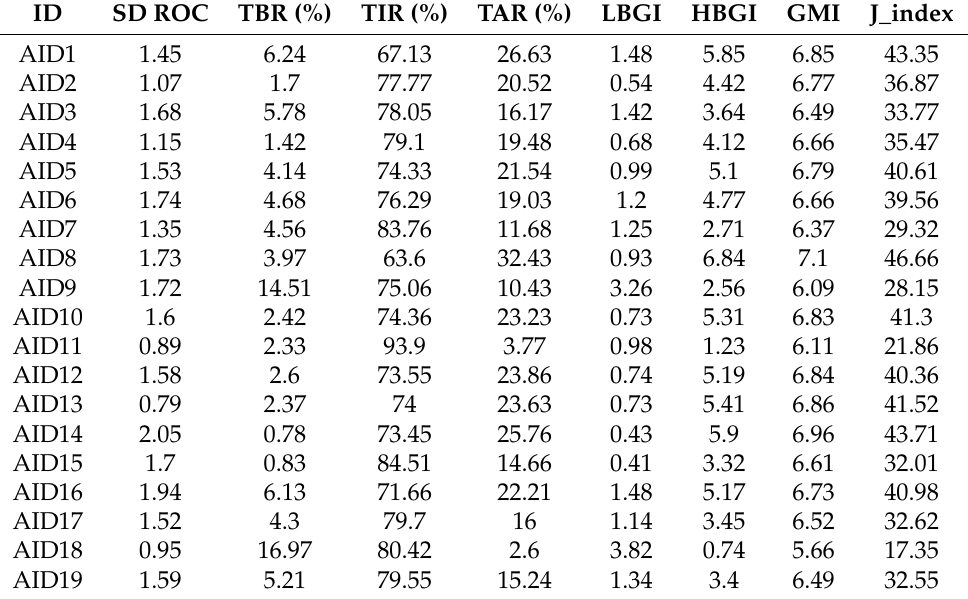
Table 5. Glucose variability outcomes for complete glucose profiles of selected AID users. Ab- breviations: SD ROC, Standard deviation for glucose rate of change; TBR/TIR/TAR, Time be- fore/inside/after range; HBGI/LBGI, High/Low blood glucose index; GMI, Glycemic manage- ment